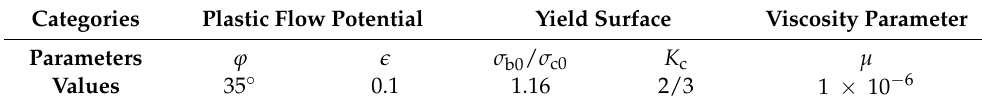
Table 2. Plasticity parameters defined in the concrete damaged plasticity (CDP)